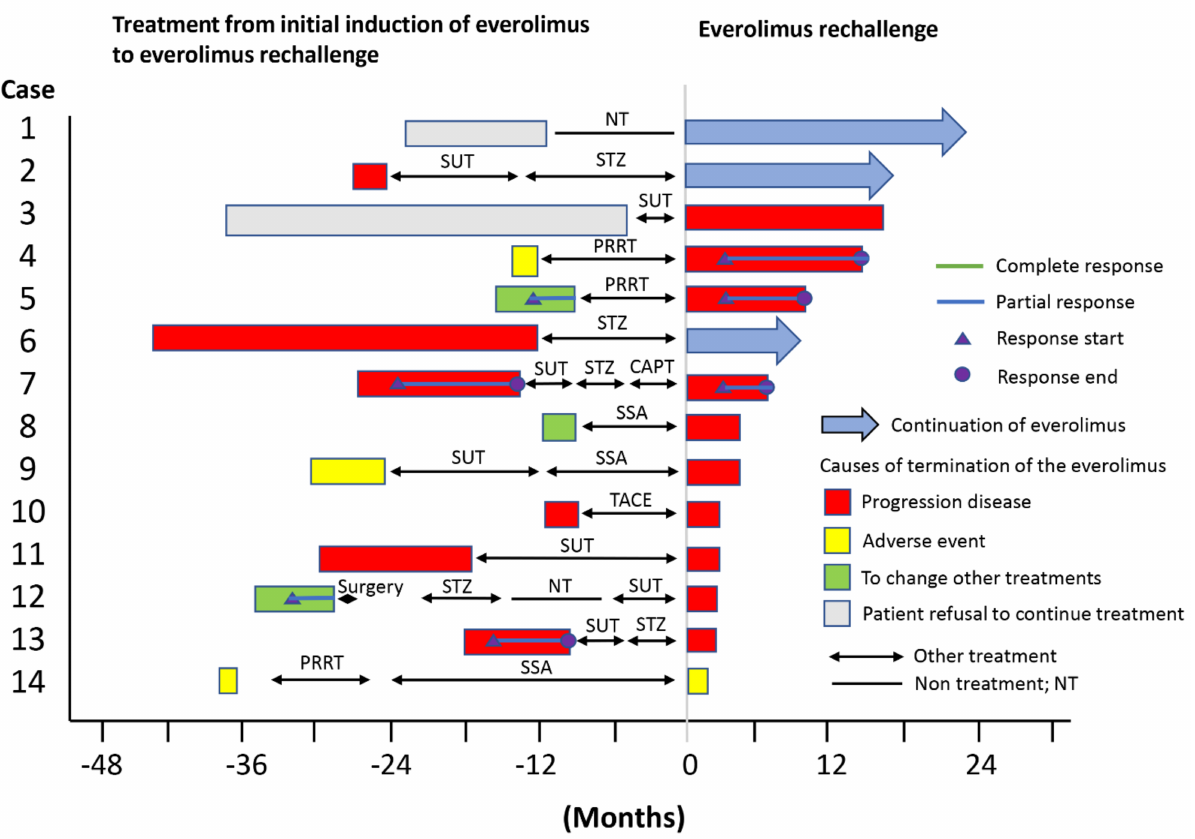
Figure 2. Swimmer plot data for everolimus rechallenge. Swimmer plot showing everolimus rechallenge and the initial introduction of everolimus and other treatments before rechallenge. CAPT, capecitabine and temozolomide; NT, non-treatment; PRRT, peptide receptor radionuclide therapy; SSA, sandostatin analogue; STZ, streptozocin; SUT, sunitinib ; TACE, transcatheter arterial chemoembolization.